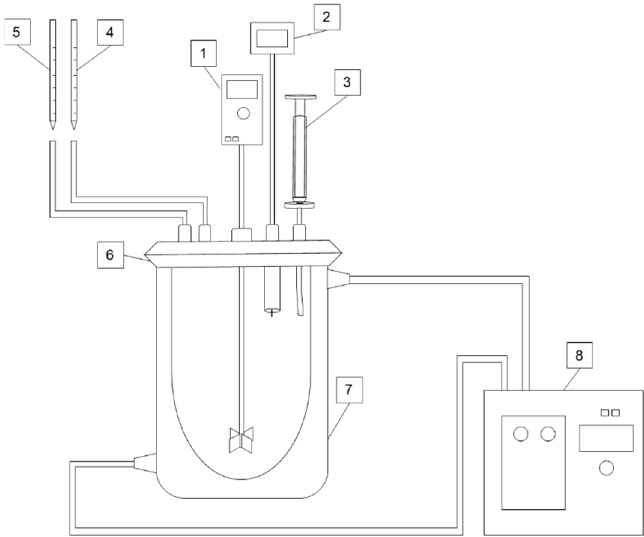
Figure 2. The schematic diagram of the leaching setup: 1. overhead stirrer; 2. pH and ORP probe; 3. sampling tube, equipped with syringe and syringe filter; 4. H 2 SO 4 ; 5. oxidant; 6. sealed lid; 7. Jacketed reactor; and 8. water bath.